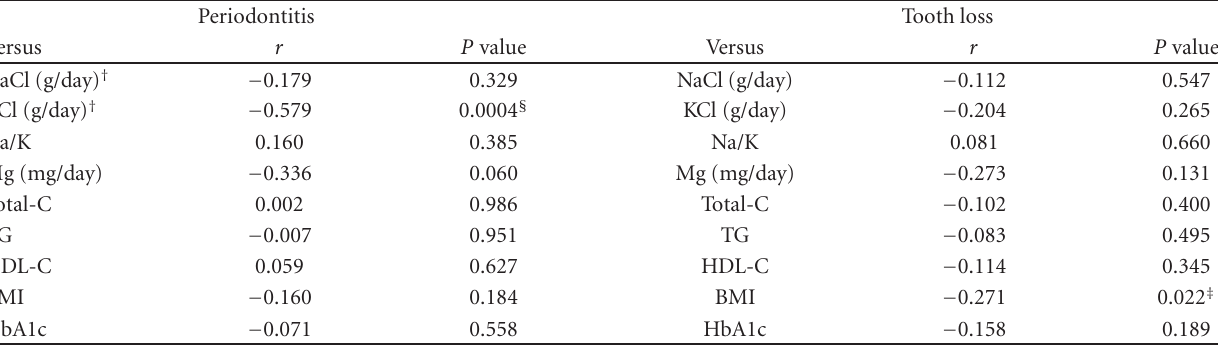
Table 3: Simple correlation coe ffi cients between periodontitis and tooth loss with traditional risk factors possibly related to hypertension in middle-aged